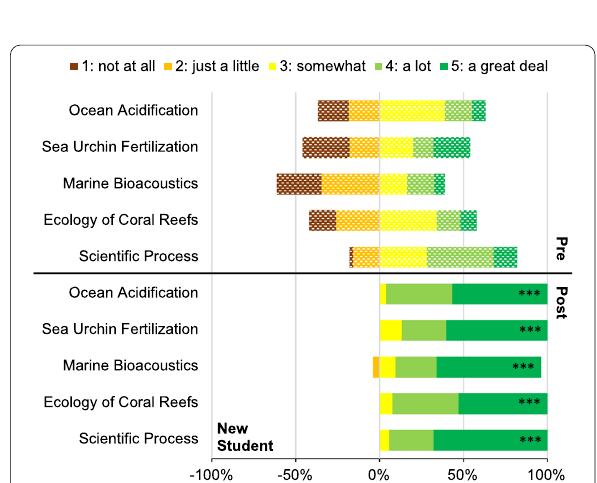
Fig. 8 Competence: Pre- and post-program new student science knowledge competence. Responses to competence REMS survey items of perceived understanding (1 relating to five (5) program modules from New Students ( N the 2016–2018 REMS programs. Differences in pre–post scores were analyzed with Mann–Whitney U -tests. *** p < 0.001